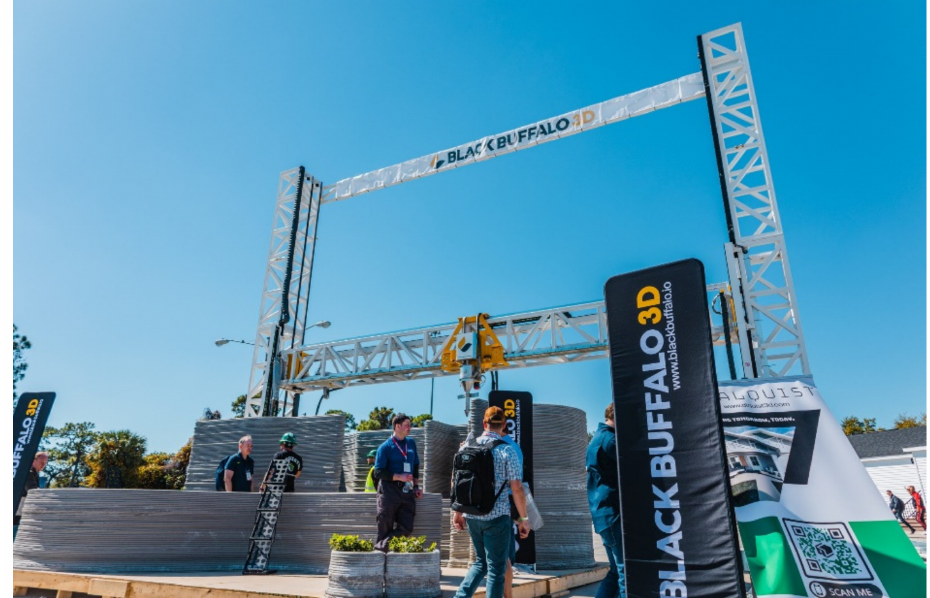
Figure 6. Black Buffalo gantry printer [4]. Reprinted with permission from Ref. [4]. 2022, Black Buffalo